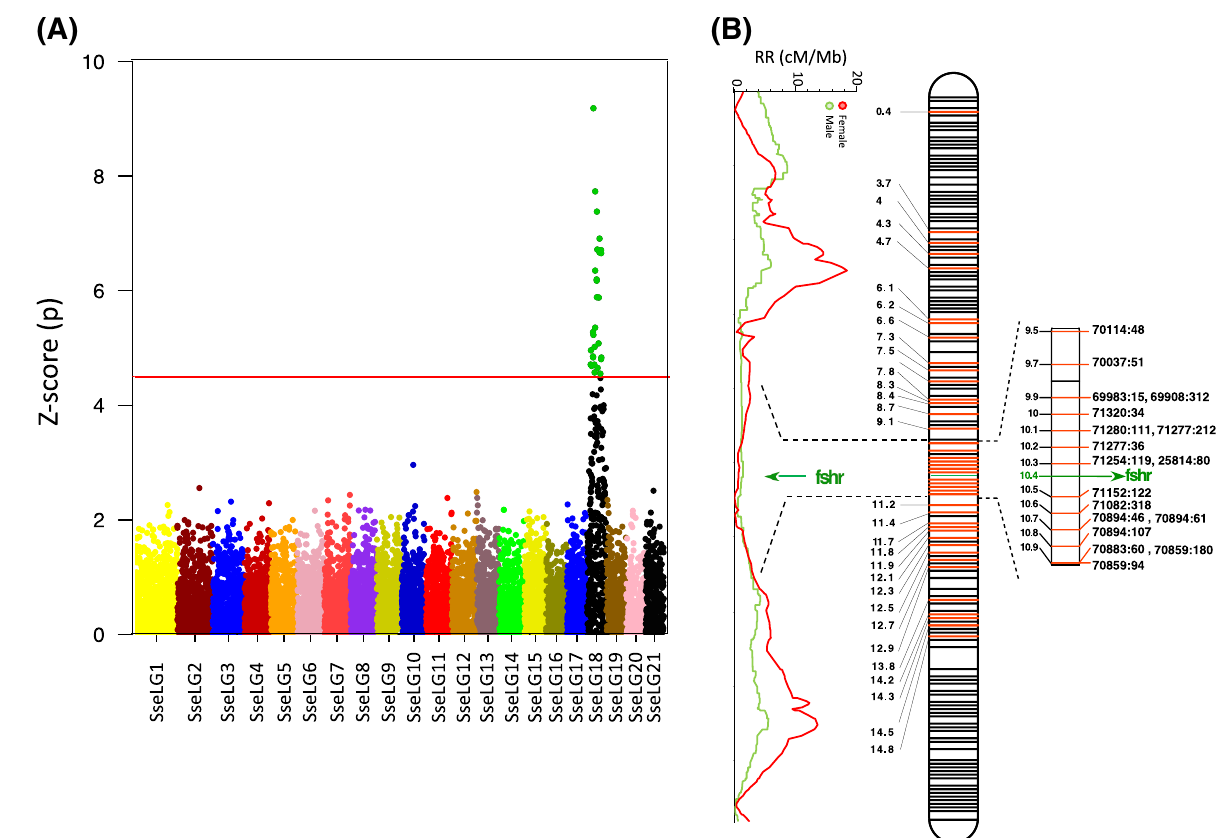
Figure 6. Sex-associated SNPs and RR landscape for males and females in SseLG18. ( A ) Manhattan plot of GWAS results for sex-associated SNPs using seven families. Significant markers are indicated in green. The horizontal red line represents the Bonferroni significance threshold. ( B ) Distribution of all 66 sex-associated significant markers using seven families and by family (in red, Supplementary Table S5) and RR (cM/Mb) landscape of males and females. A hot region from 9.5 to 10.9 Mb containing the candidate gene fshr is indicated on the right side. Physical positions of SseLG18 in Mb are indicated in black. Black lines indicate non-significant markers in